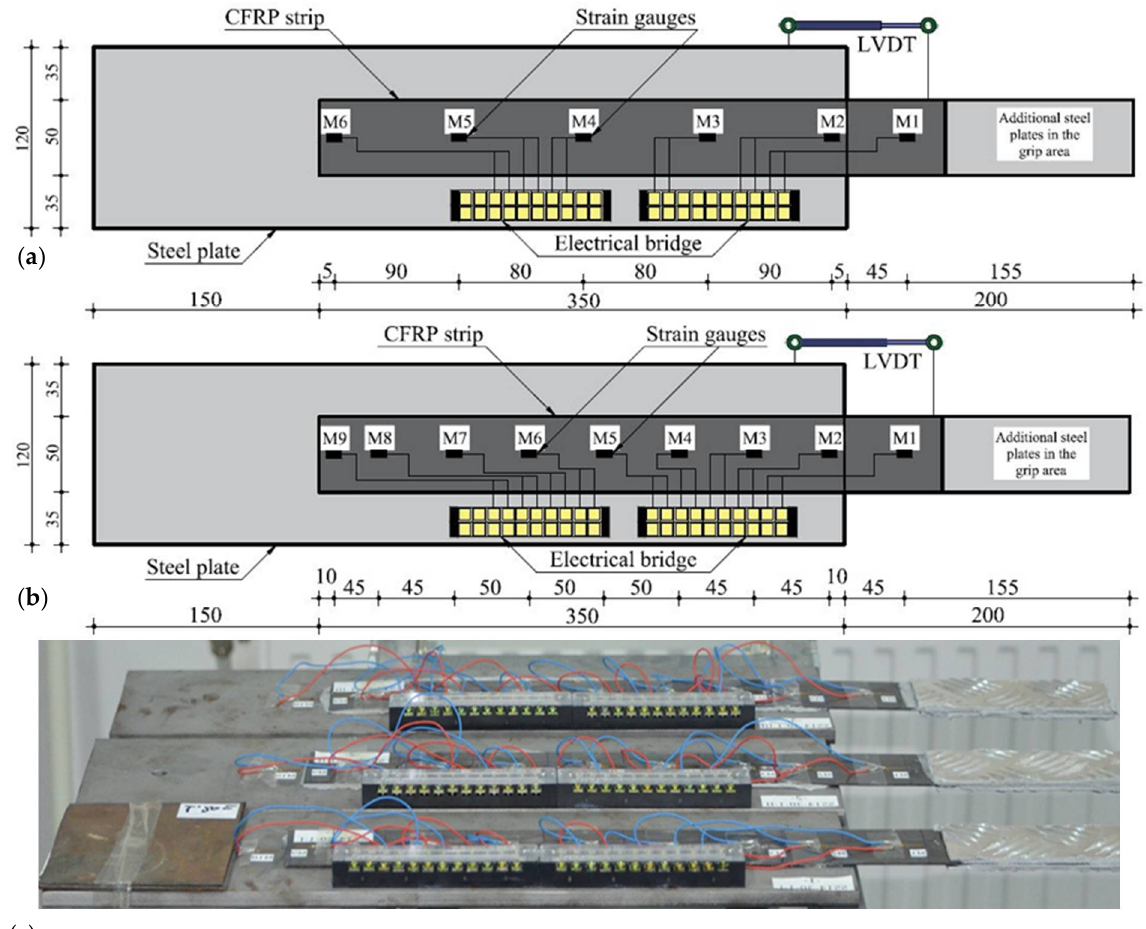
Figure 5. Specimens instrumentation with strain gauges and LVDT (dimensions in mm). ( a ) Graphical representation of specimens with 5 strain gauges, ( b ) Graphical representation of specimens with 9 strain gauges, ( c ) Real specimens with 9 strain gauges.